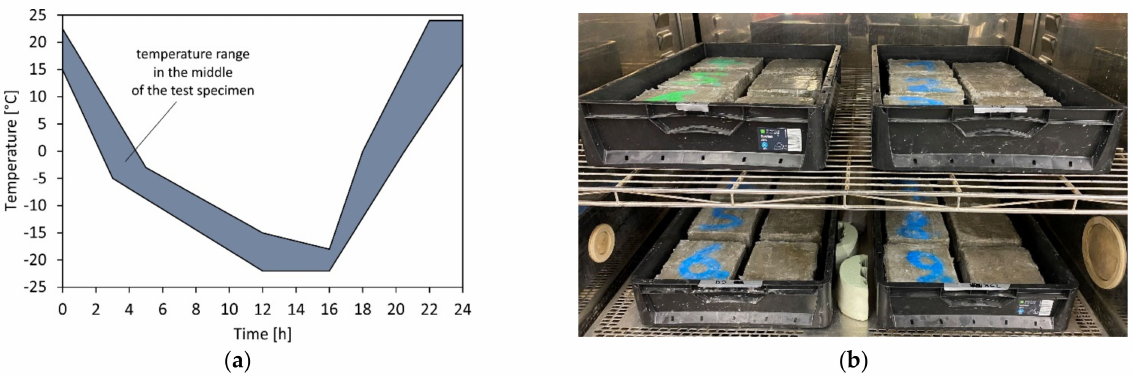
Figure 3. Temperature curve for the freeze–thaw tests in accordance with the specifications provided in [15] ( a ) and test performance in the climate chamber (( b ); model Weiss WK1000).